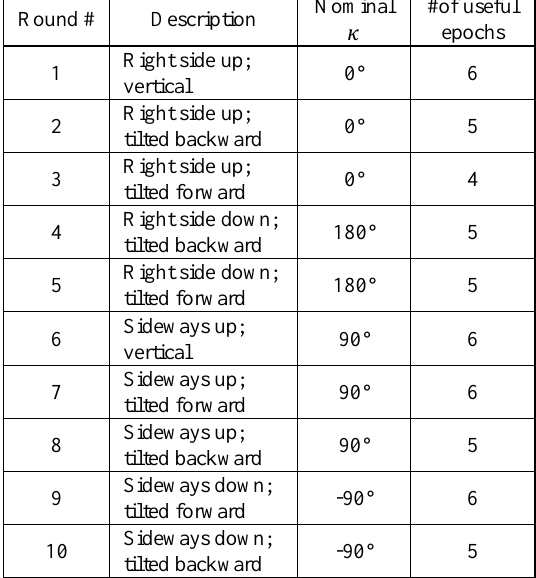
Figure 4. The coordinate system used for a particular camera (a); the calibration test field showing the origin and the orientation of the local coordinate system (b)